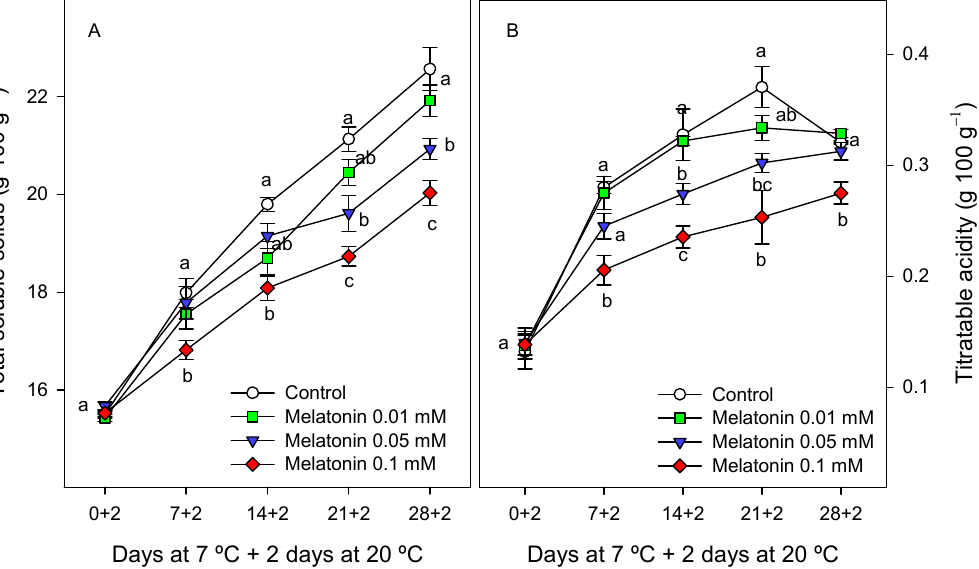
Figure 5. Total soluble solids ( A ) and titratable acidity ( B ) as affected by melatonin (0.01, 0.05 and 0.1 mM) treatments. Data are the mean ± SE of three replicates. Different letters show significant differences ( p < 0.05) among treatments for each sampling date.